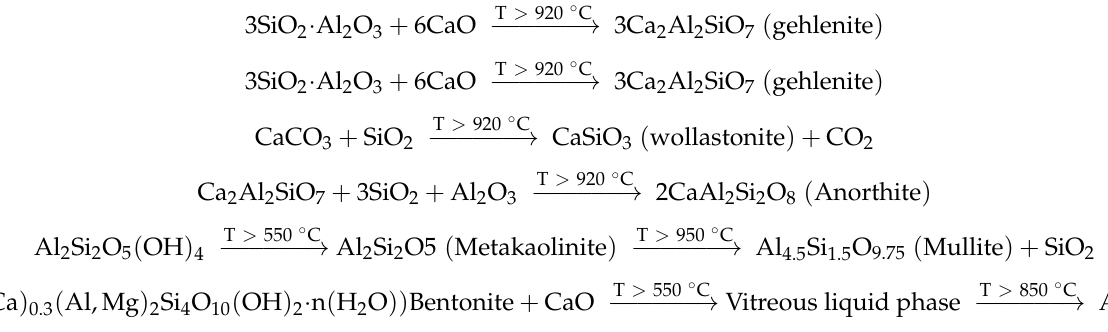
Figure 4. Physical aspect of membranes after sintering at 1150 °C.